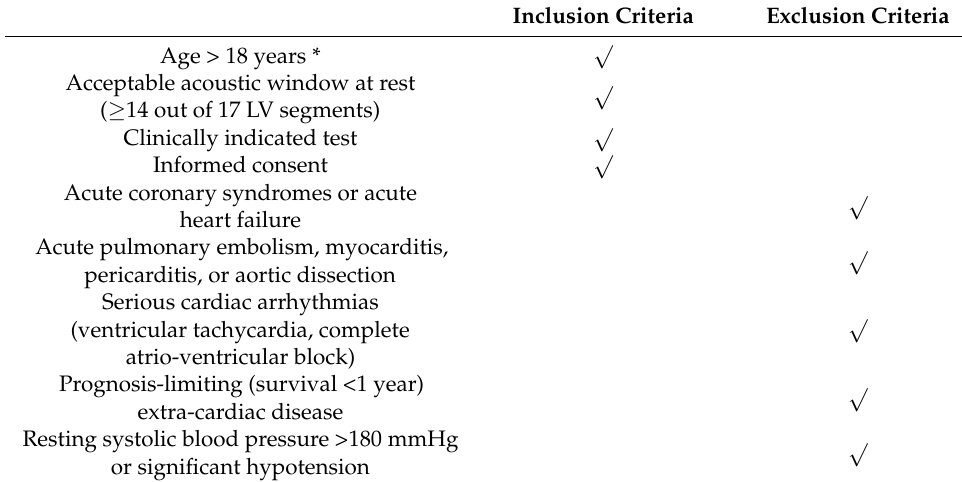
Table 1. General inclusion/exclusion